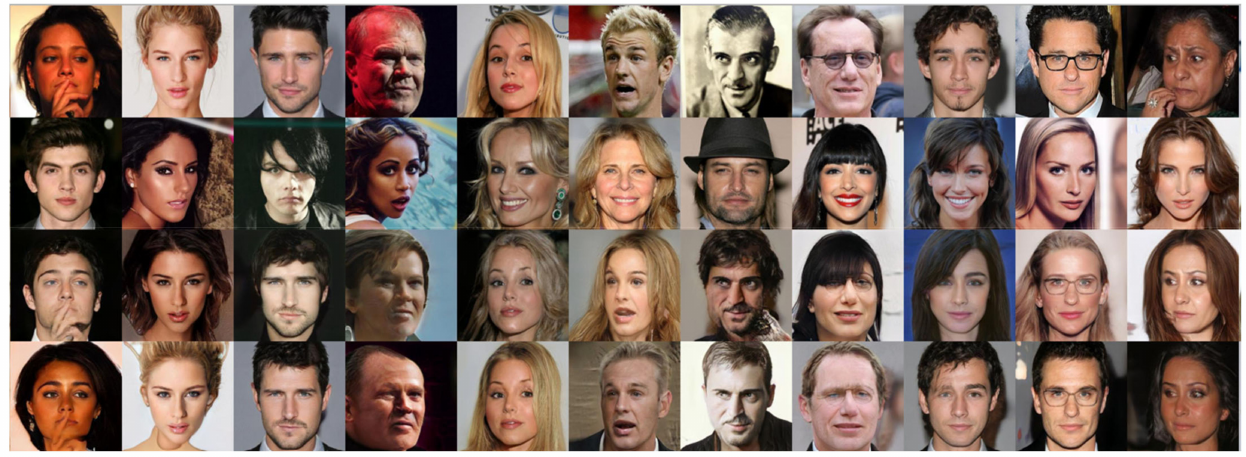
Figure A1. Images generated by cycle consistency (The first and second rows are real